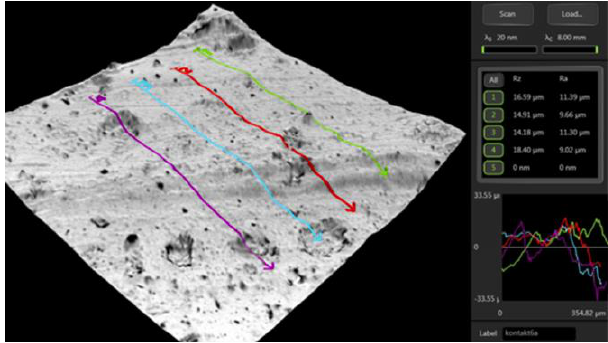
Fig. 12. Sample number 3, measurement 1 – 3D view of the test surface